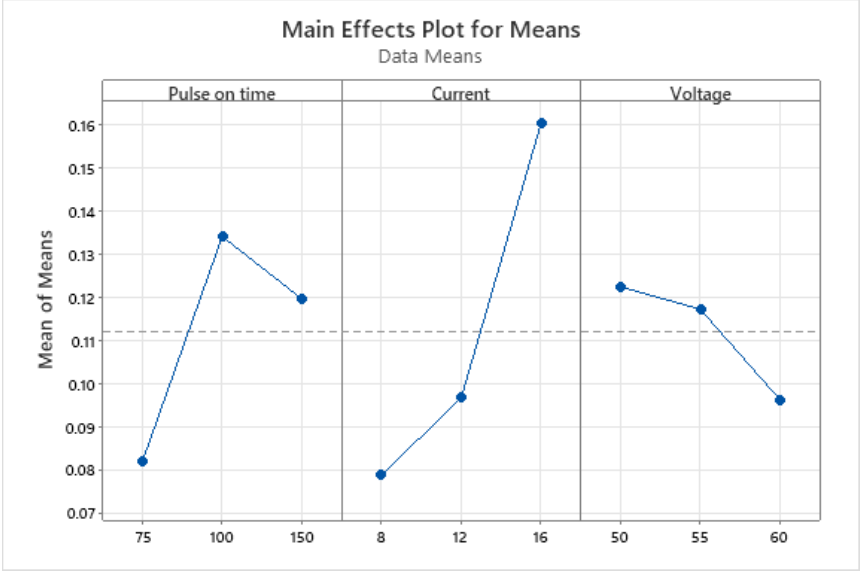
Figure 7. Main effects plot for means (pulse-on time is in µs, current in amperes, and voltage in